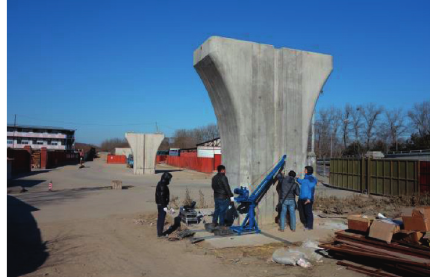
Figure 2: The test bridge pier-cap-pile system.